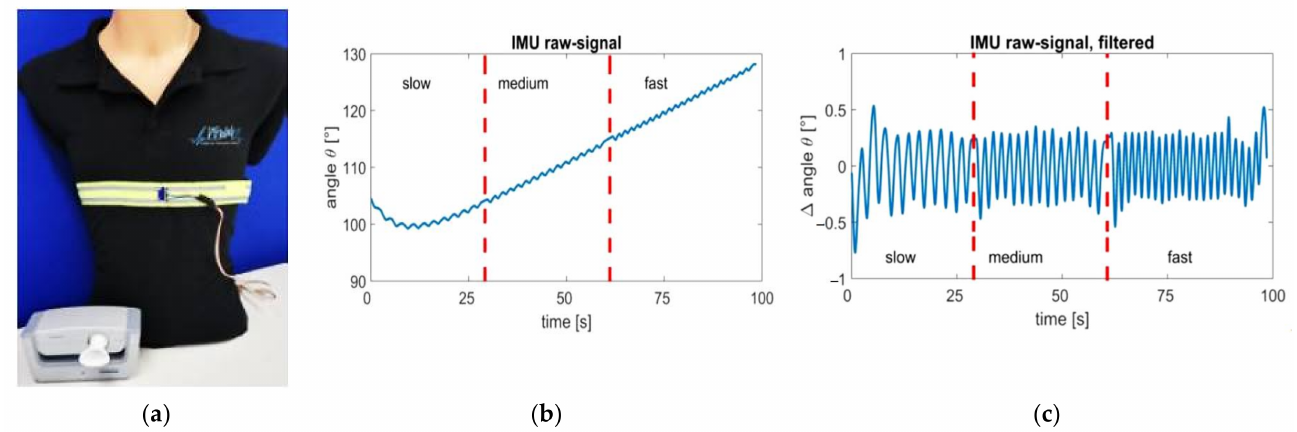
Figure 7. IMU-belt proposed in [110] with the reference spirometer ( a ); IMU-signal raw ( b ), and filtered ( c )